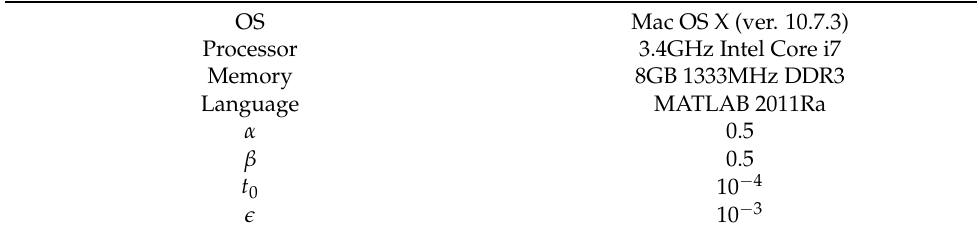
Table 2. The outline of experimental